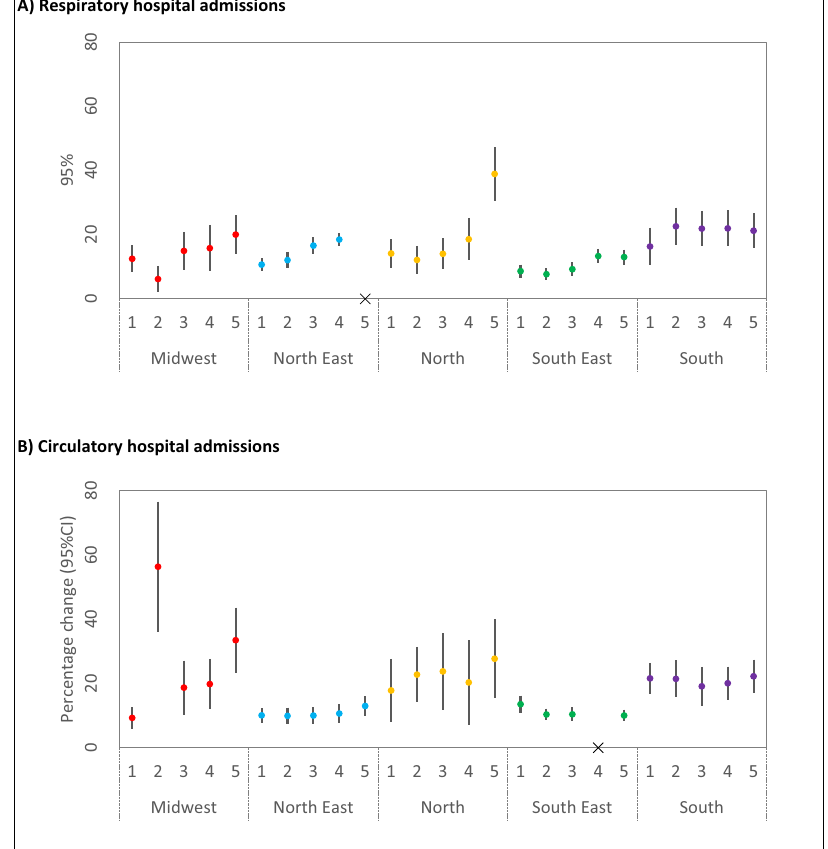
Fig. 2 Association between hospital admissions and wild fi re-related PM2.5. Regional percentage increase in risk (and 95% CI) of hospital admissions ( A , respiratory diseases; B , circulatory diseases) associated with wild fi re-related PM 2.5 in wild fi re waves for the moving averages 1 – 5 days. Note 1: Numbers in x -axis indicate the moving averages. Note 2: “ x ” means that there were very large groups of ties, which a large number of health events (de fi ned as case day) is out of a large number of subjects (case plus control days). The algorithm in the Survival package may refuse to undertake the task (the computation is infeasible) due to over fl ow for the subscripts. Note 3: Red (Midwest), blue (North East), orange (North), green (South East), and purple (South). Note 4: n = 2,044,038